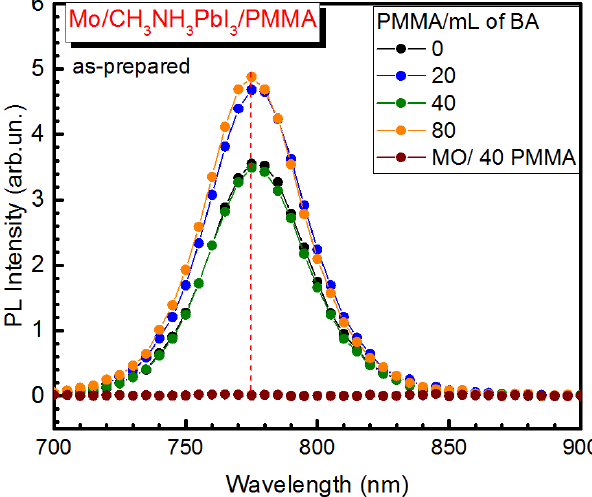
Figure 5 . PL spectra for perovskite coated with 0, 20, 40, and 80 mg/mL of PMMA and for 40 mg/mL PMMA on Mo substrate.